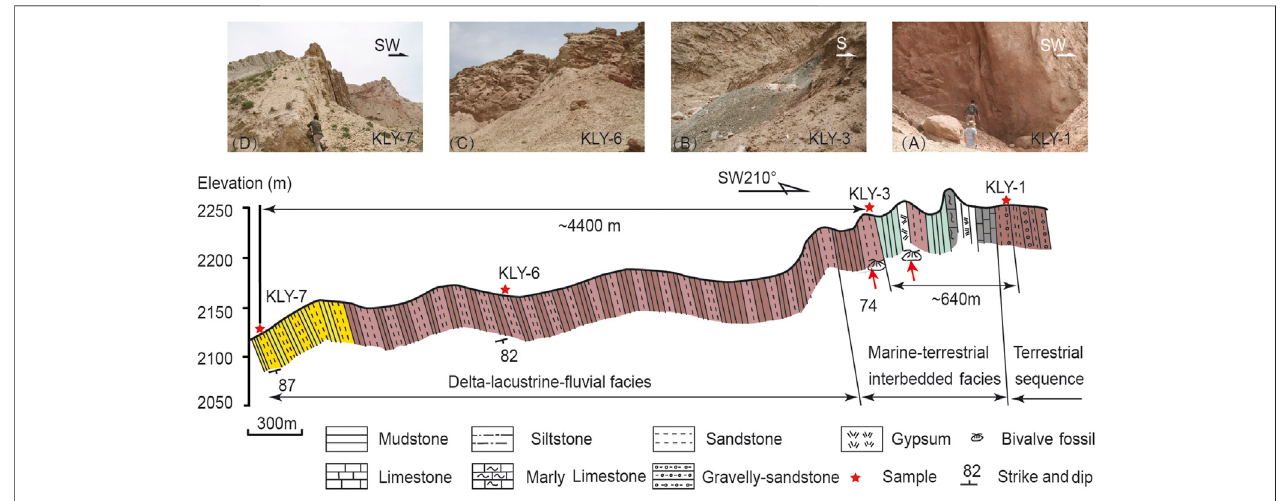
FIGURE 3 | Cross-section of the Keliyang area in the SW Tarim Basin (A) , Sandstones intercalated with gravel; (B) , Green mudstones with interbeds of siltstones; (C) , Orange-red sandstone; (D) , Light yellow sandstone.